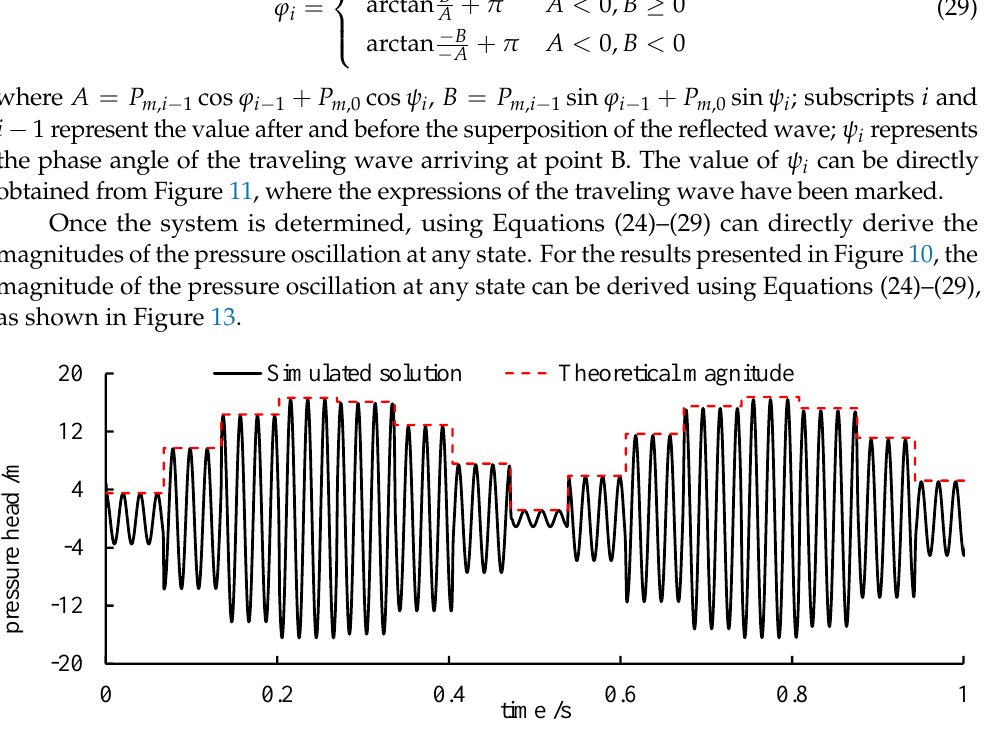
Figure 13. Theoretical magnitude of the pressure oscillation.